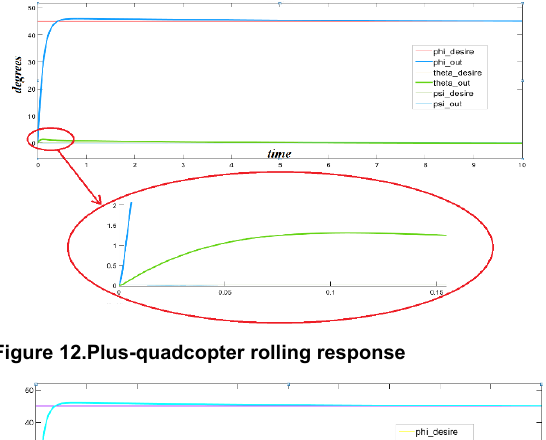
Figure 12.Plus-quadcopter rolling response